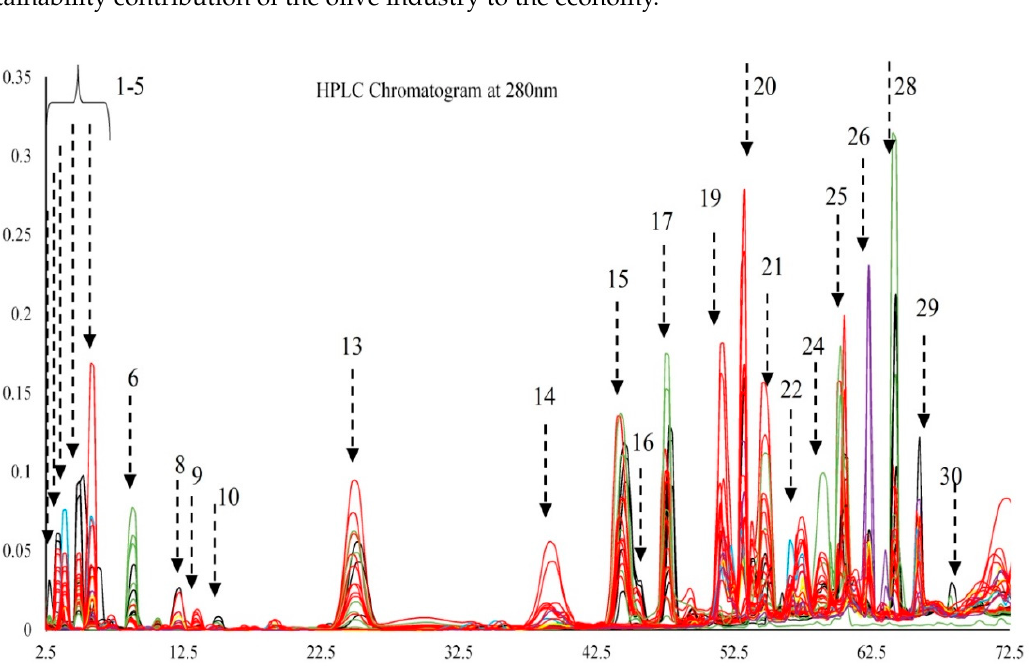
Figure 1. Phenolic chromatogram observed at 280 nm and 320 nm obtained for all the monocultivar EVOOs studied. Different colors represent olive oils derived from different geographical origin. Black = indigenous Maltese cultivars; green = foreign cultivars that are locally grown; red = Italian cultivars; blue = Greek origin; purple = French origin and yellow = Spanish origin. 5. Conclusions This paper achieves a profile based on the separation of polyphenols in EVOOs; for both indigenous and foreign but locally derived EVOOs from the Maltese islands. Evidence that ultimately certain polyphenols were dependent on the pedo ‐ climatic conditions and not solely on the genetic component of the originating olive tree is also presented.